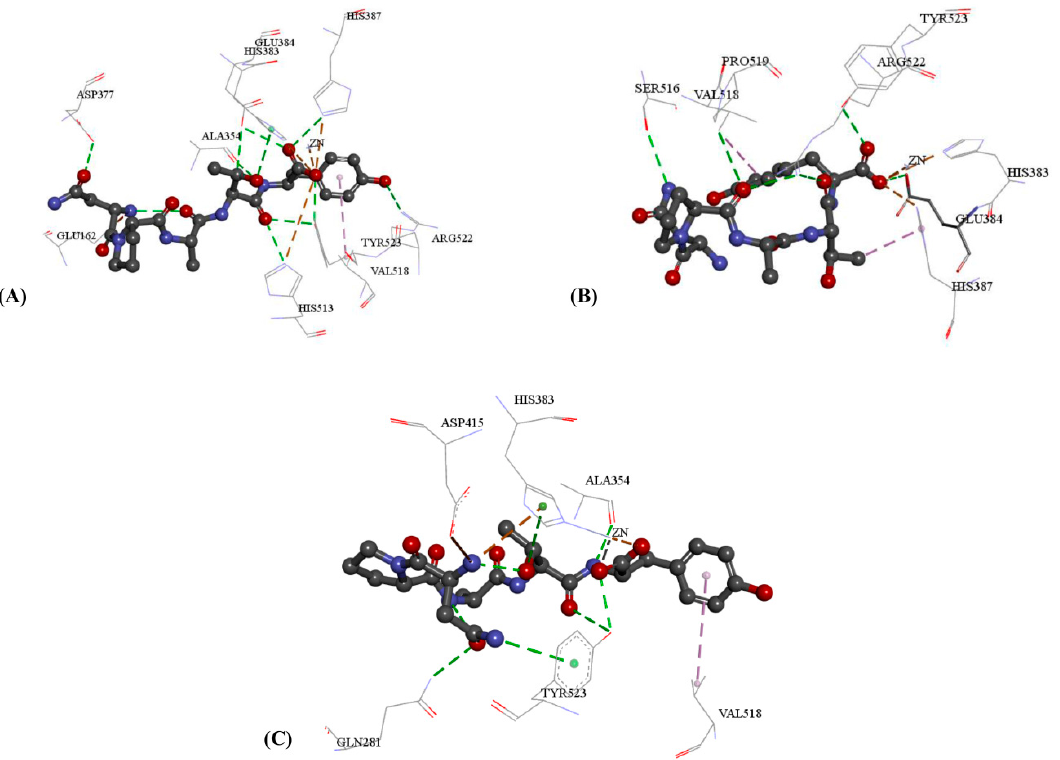
Figure 4. The 3D key interaction between NPATY and three crystal structures: ( A ) 1O86 and NPATY; ( B ) 4BZR and NPATY; and ( C ) 4CA5 and NPATY. Wherein, green dash lines represent hydrogen bond; orange dash lines represent electrostatic interaction; and pink dash lines represent hydrophobic effect.